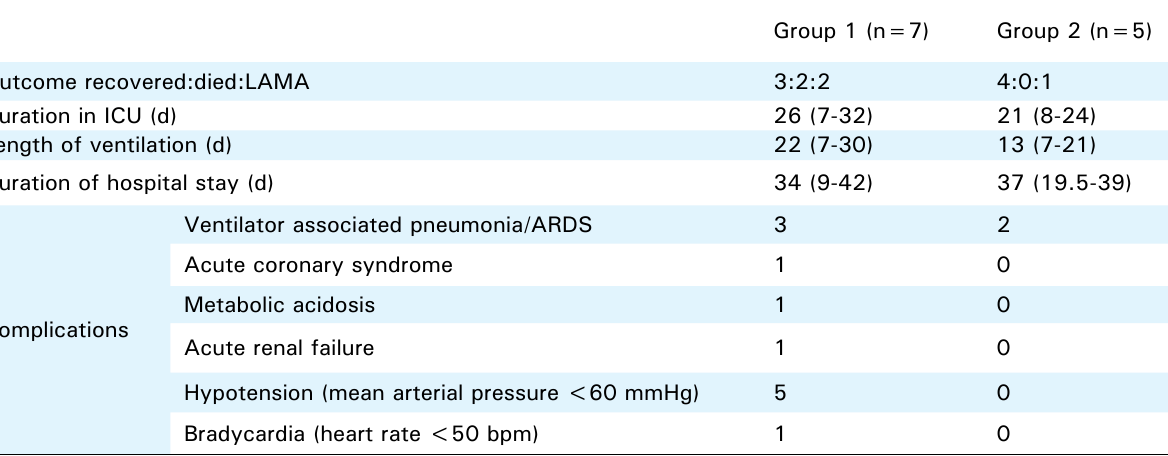
table 3. Comparison on the patient outcome between groups. Values are expressed as median (interquartile